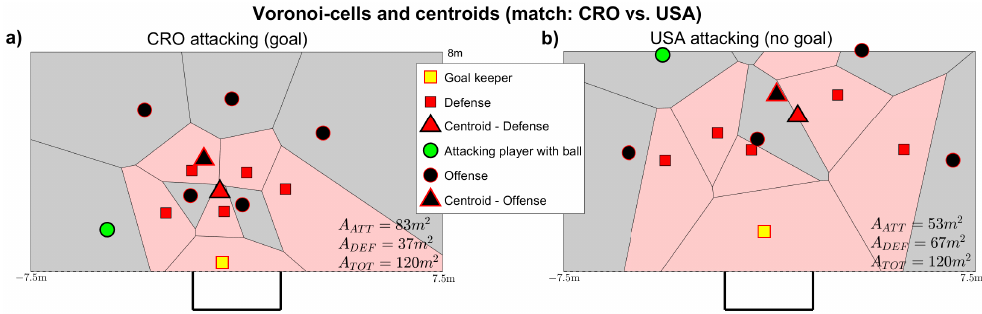
Figure 10. Exemplary collective space control for offense and defense visualized by Voronoi-cells separated in attacking (gray) and defensing (red) zones with the corresponding space control areas A ATT and A DEF (within the preliminary round game CRO-USA). ( a ) CRO attacks scoring a goal. ( b ) USA attacks not scoring a